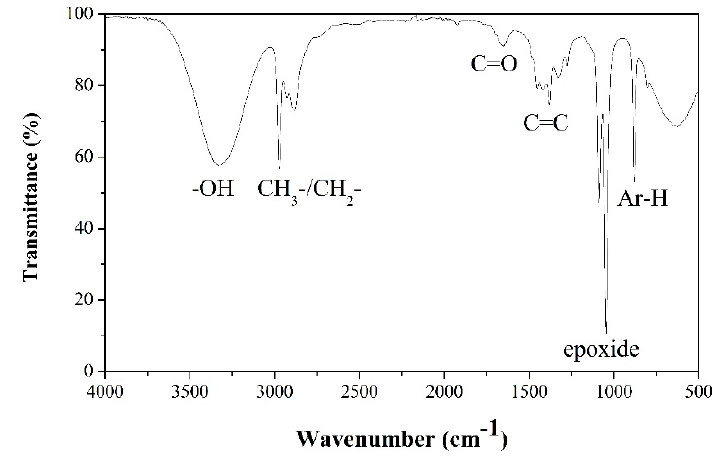
Figure 2. Fourier-transform infrared spectroscopy spectrum of the synthesized carbon nanodots.